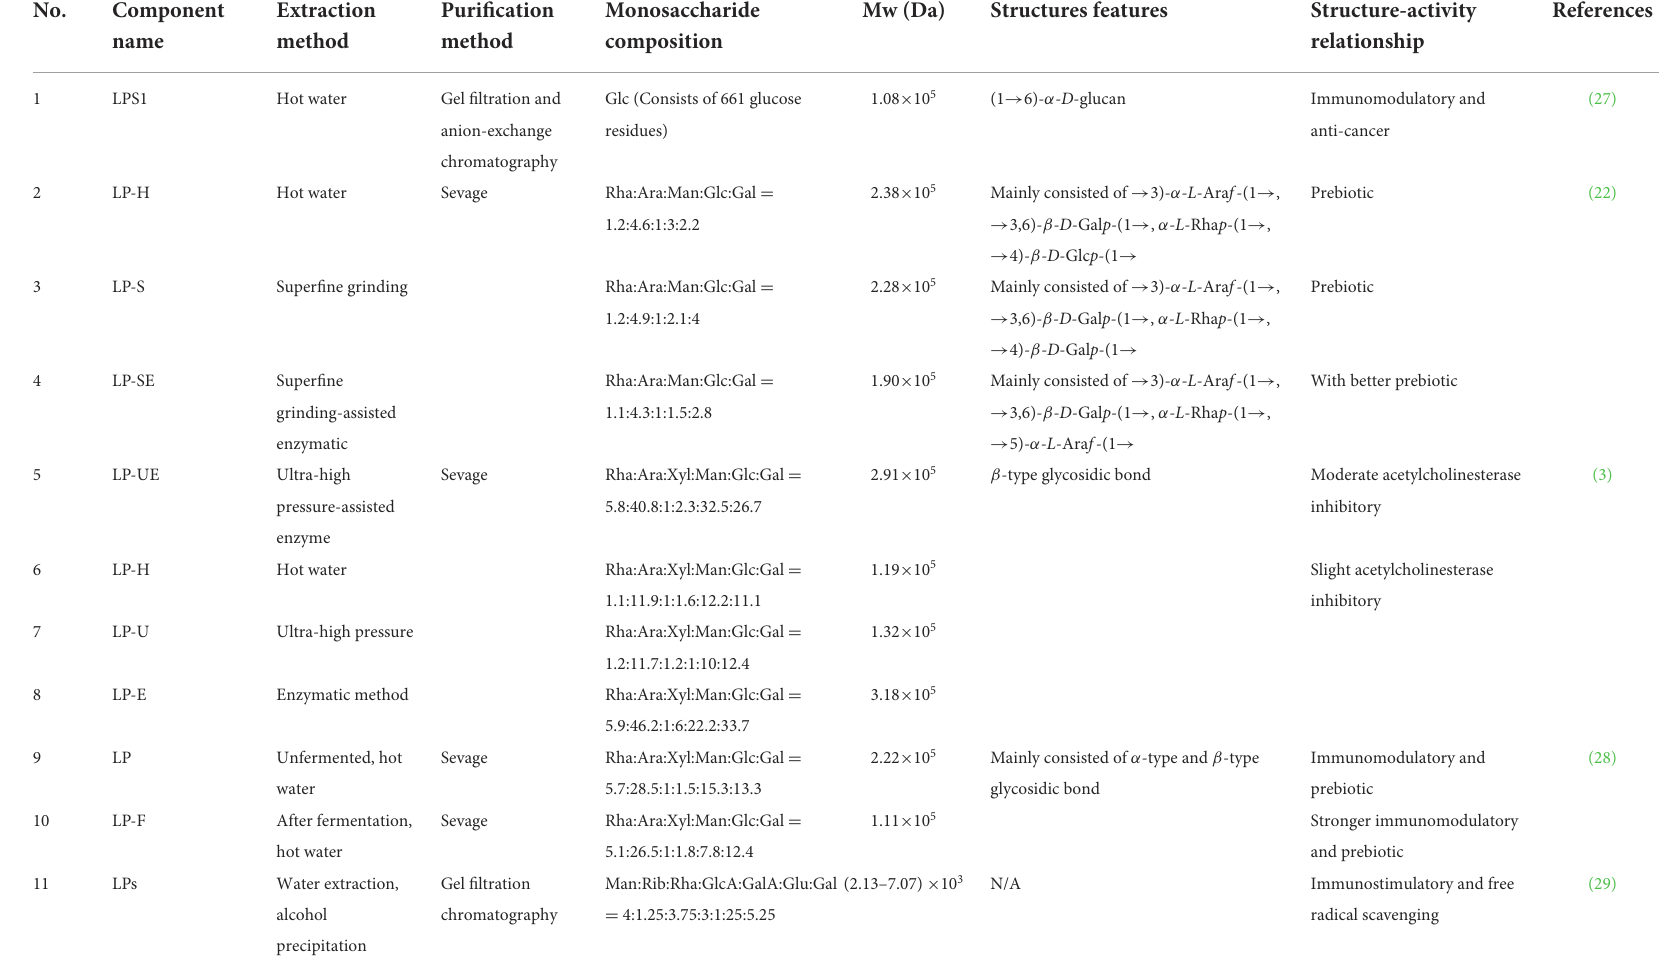
TABLE 1 The extraction, purification, and structural characterization of polysaccharides from the longan fruit pulp.